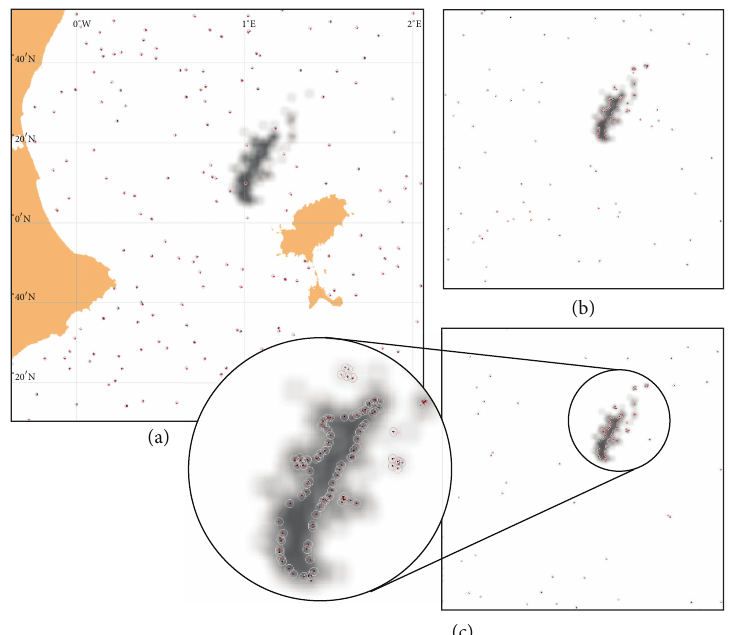
Figure2:Distributionofagentswithrespecttotime(inseconds)forthetaskofdetectingtheperimeterofanoilspill:(a)geographicallocation of the spill and initial position of agents, (b) distribution of agents at time 𝑡 = 15000 s, and (c) distribution of agents at time 𝑡 = 30000 s.